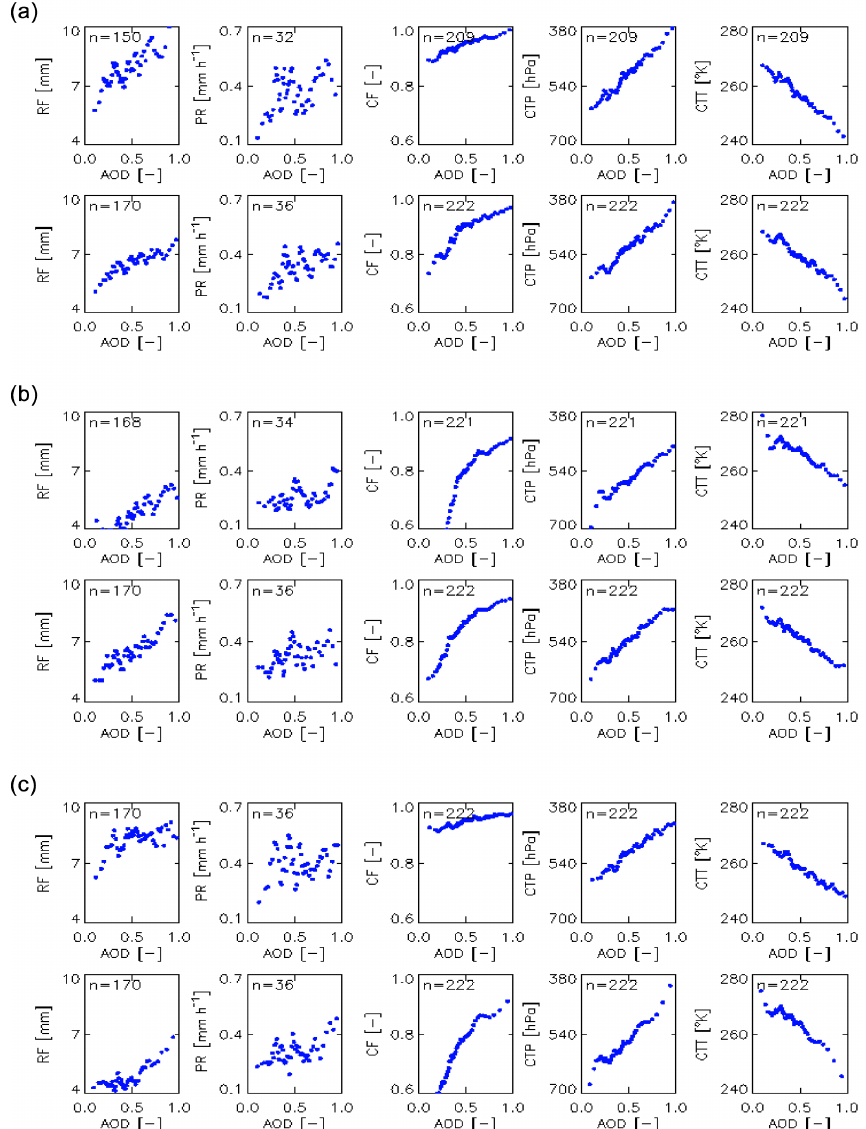
Figure 11. Associations of accumulated daily rainfall, precipitation rate, cloud fraction, cloud top pressure, and cloud top temperature with AOD. (a) Data slicing by the wind shear for the lower regime (0–33%, top) and the higher regime (67–100%, bottom). (b) Same as panel (a) , except data slicing by the relative humidity. (c) Same as panel (a) , except data slicing by the geopotential height. The methodology of creation of the scatter points was similar to that used for Fig. 3. Each scatter point is the average of these equal “ n ” numbers of data points mentioned in each respective